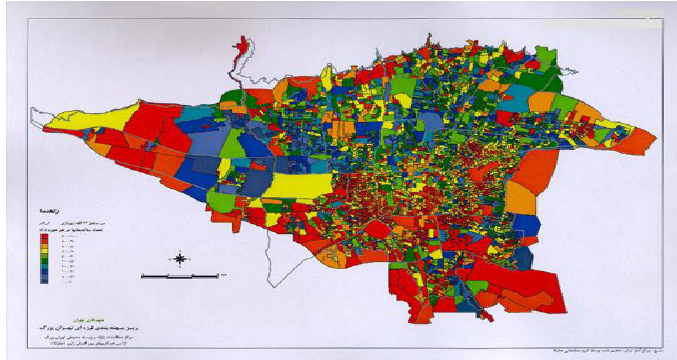
Fig. 2. Dispersion of poorly assessed buildings in Tehran.